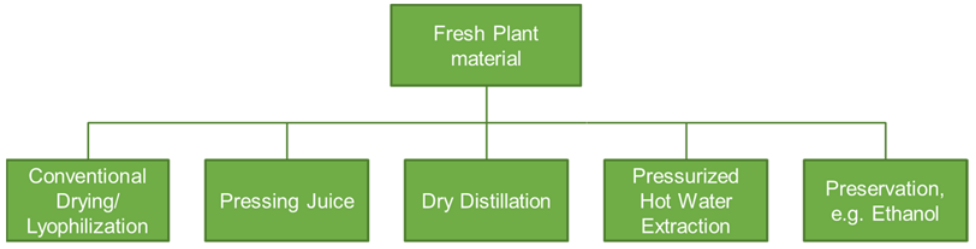
Figure 6. Options for processing freshly harvested plant